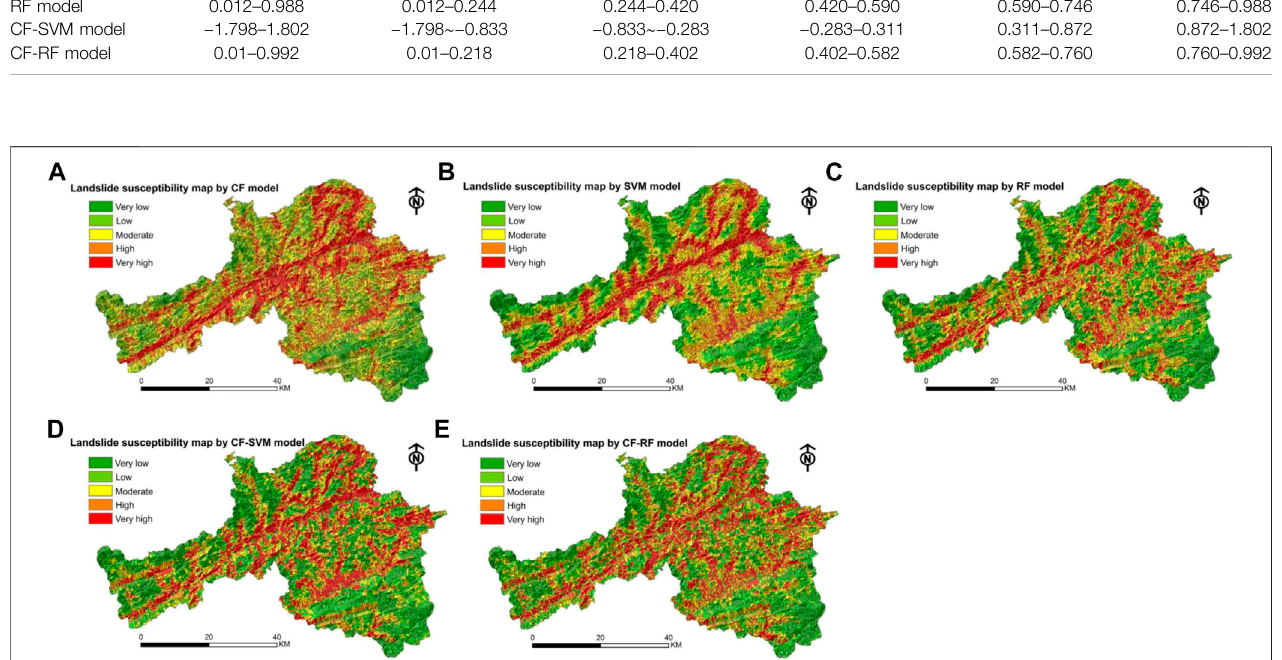
FIGURE 6 | Landslide susceptibility maps produced from: (A) the CF model, (B) the SVM model, (C) the RF model, (D) the CF-SVM model and (E) the CF- RF model.